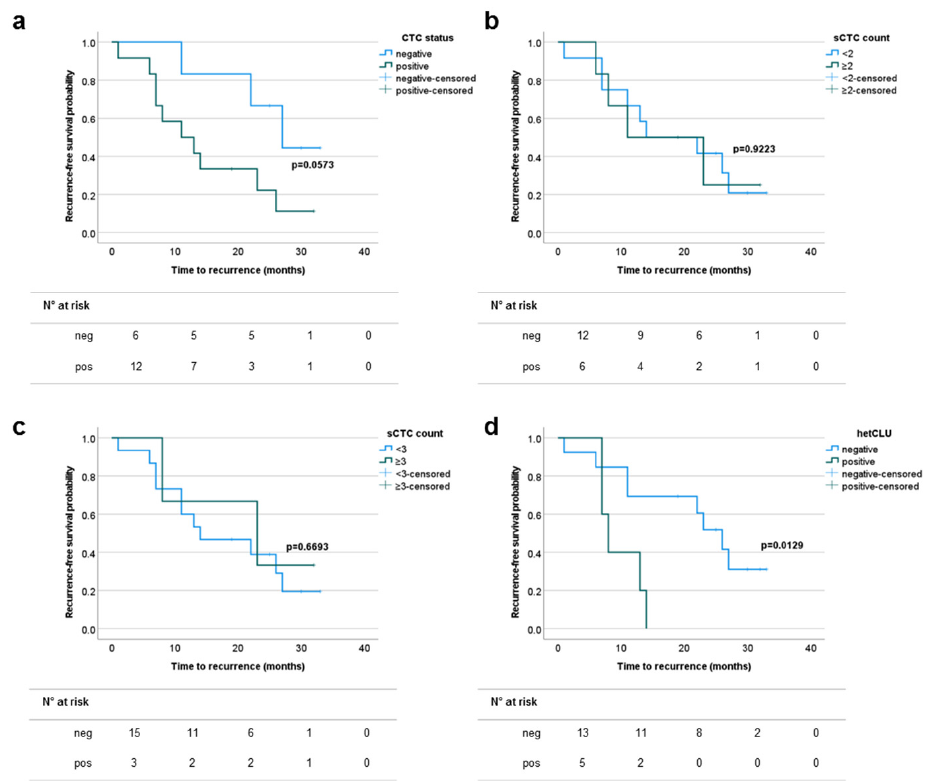
Figure 4. The presence of heterotypic circulating tumor cell clusters (hetCLU) correlates with reduced recurrence-free survival in stages III and IVA non-small cell lung cancers. Kaplan–Meier plots showing the time-to-event probability of disease recurrence according to ( a ) the presence of CTCs irrespective of the cell subset, ( b , c ) the prevalence of single CTCs (sCTC) or ( d ) the presence of